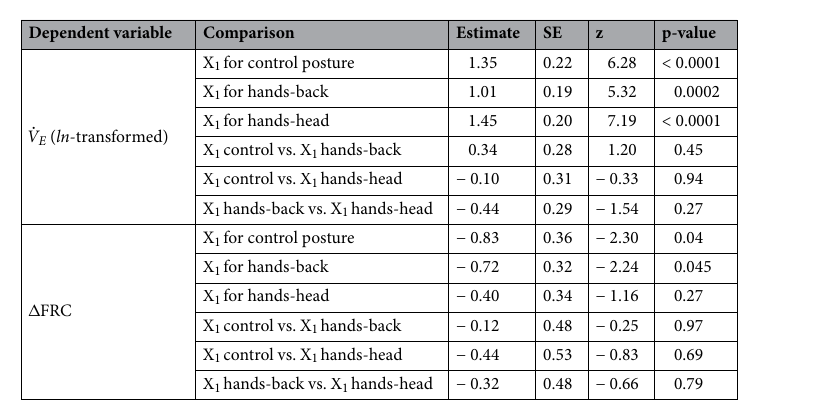
Table 5. Analysis of changes in breathing during X 1 , the first minute of post-exercise weighted restraint (n = 291 breaths from 17 subjects). The first three rows for each parameter test whether the mean of values observed ˙ V in X 1 differed significantly from phase R. E was significantly higher than phase R for all postures and (cid:31) FRC was significantly lower than phase R for the control and hands-back postures, but not the hands-head posture. There were no significant differences between postures for either parameter. Control = posture with arms at side; hands-back = restraint with hands behind back; hands-head = restraint posture with hands behind